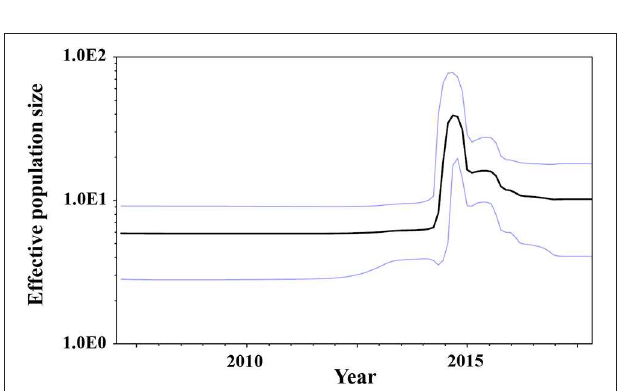
FIGURE 4 | Bayesian skyline plots for the VP1 sequences of GII.P17-GII.17 strains. The y-axis represents the effective population sizes on a logarithmic scale, whereas the x-axis denotes time in years. The solid black line indicates the mean posterior value and the intervals with 95% HPDs are shown by blue